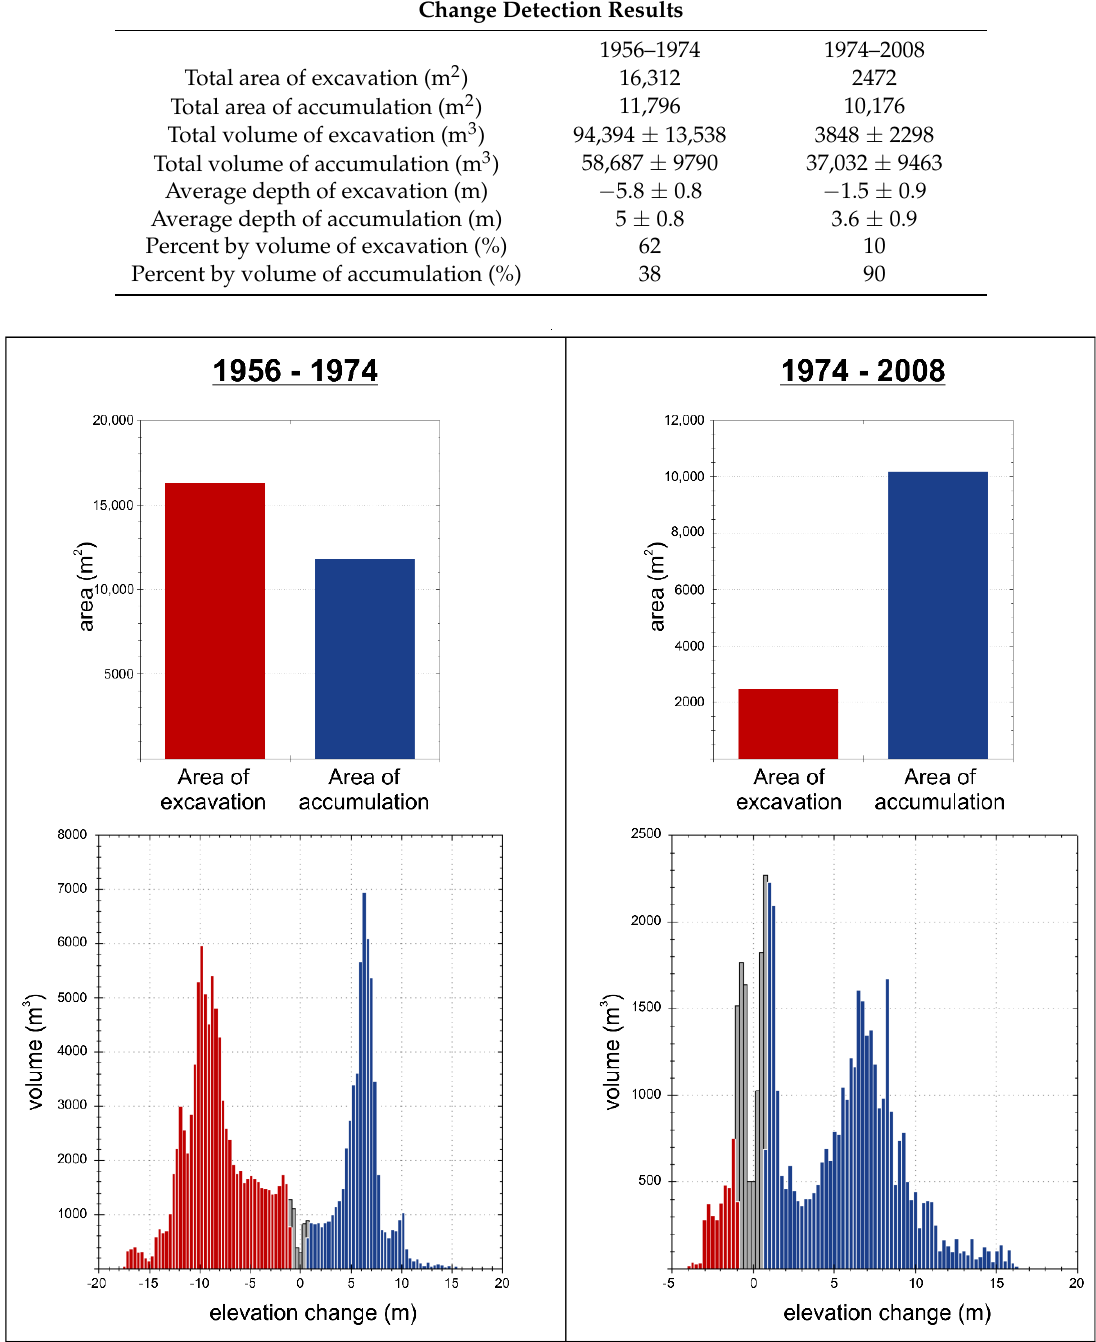
Table 2. Thresholded results of the change detection analyses.